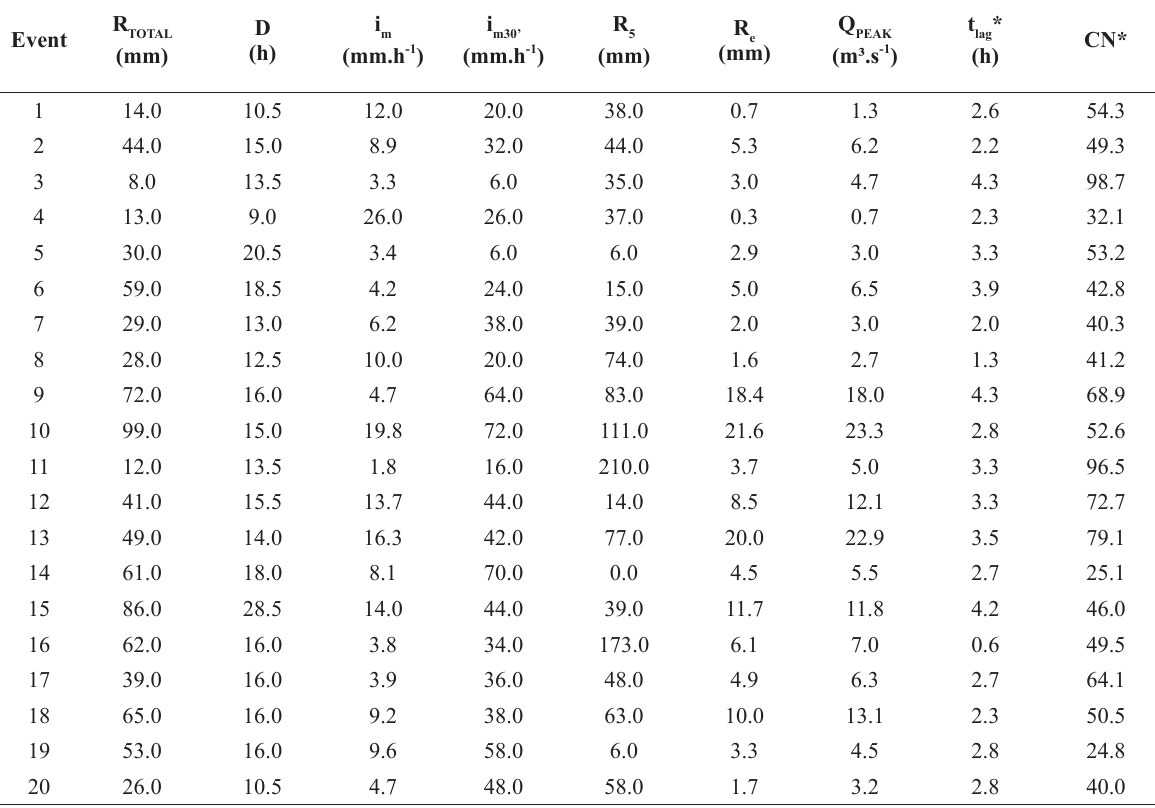
), TOTAL ), maximum mean 30-minute intensity (i ), antecedent 5-day rainfall m m30’ ), observed lag time (t *) and adjusted curve PEAK lag number